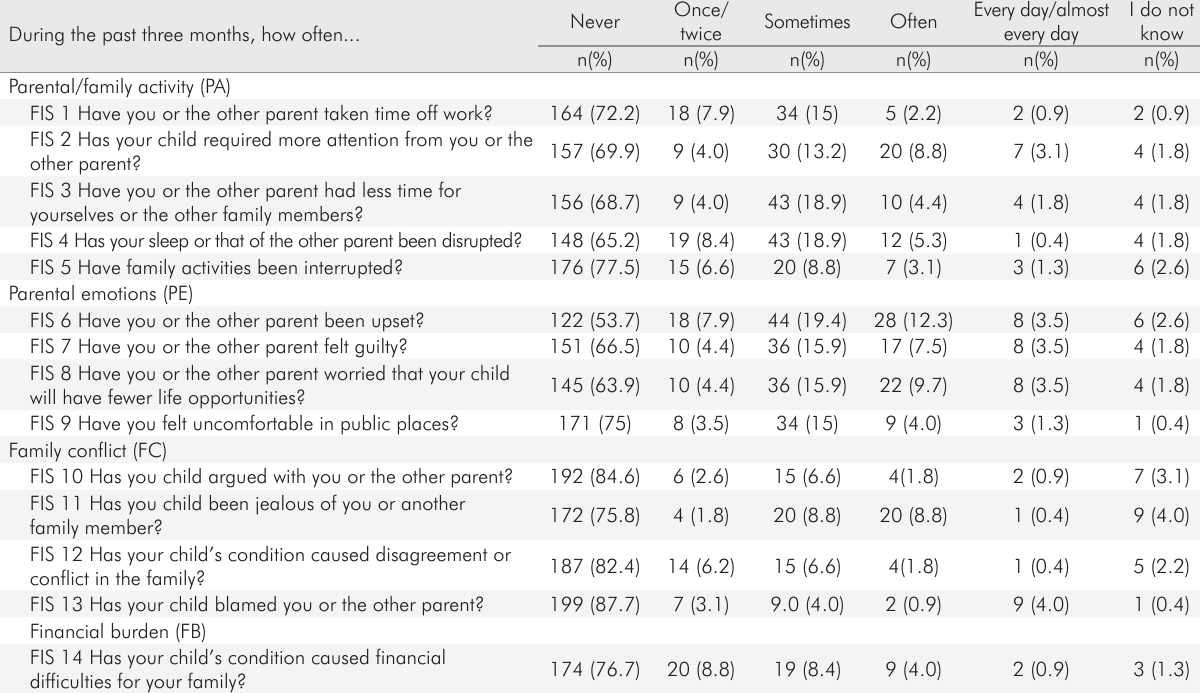
Table 3. Percentage distribution of parents’ response on the B-FIS (n = 227). During the past three months, how